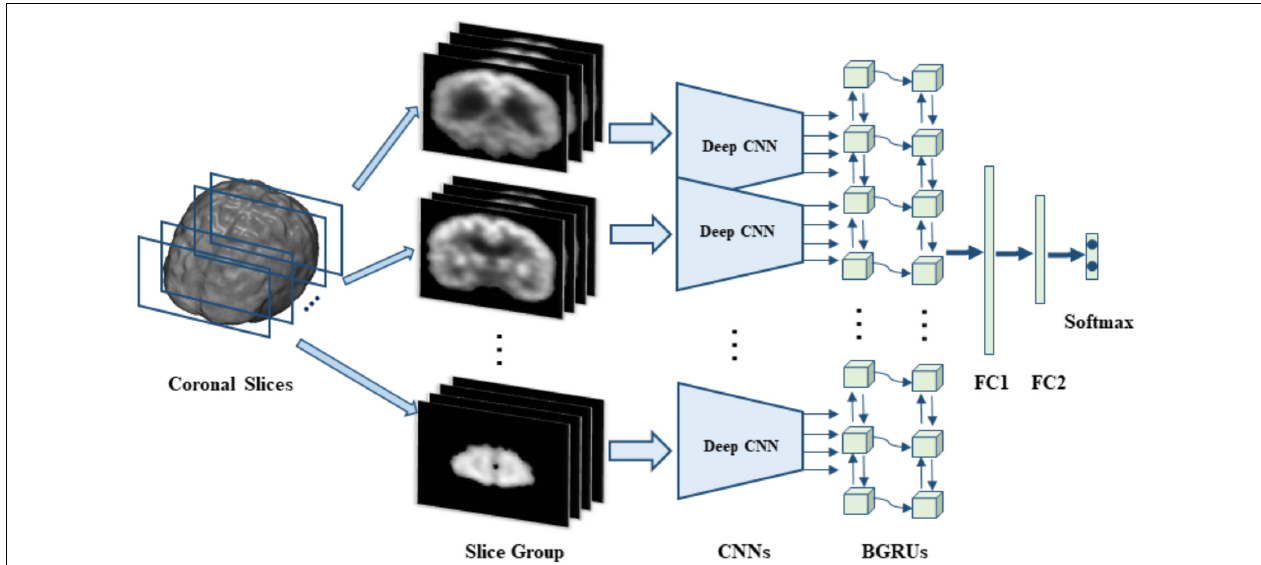
FIGURE 1 | The flowchart of our classification framework for the sagittal direction, we first decompose 3D PET image into many groups of slices and then build a deep CNN to capture the intra-slice features for each group while two stacked BGRU layers are trained to capture the inter-slice features. On top of BGRUs, two fully connected layers (FC1 and FC2) and one softmax layer are added to make classification prediction.